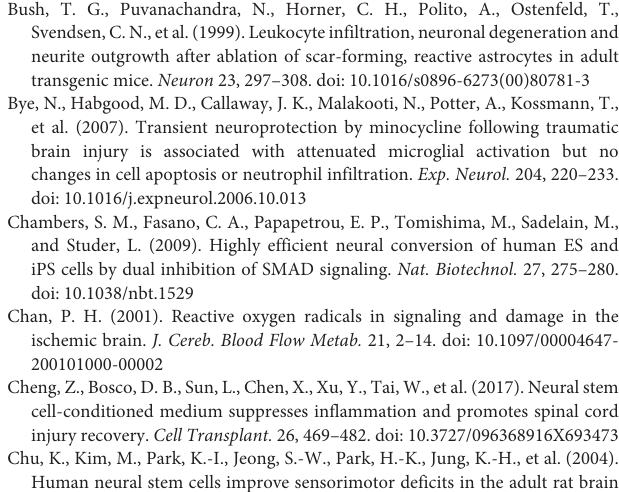
SUPPLEMENTARY FIGURE 1 | The average total DAPI+ cell per field-of-view was evaluated for each replicate ( n = 3); GFAP and CSPG were co-labeled. HGF-NPC-CMs contained a greater number of cells per field-of-view than that of untreated cells ( p = 0.02). Error bars represent ±